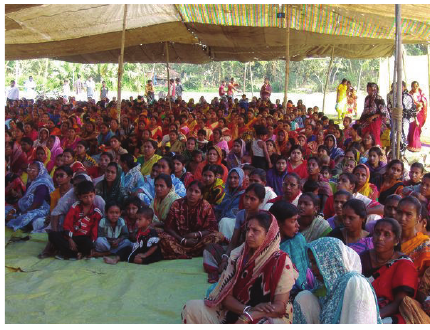
Figure 1: Educational activities on nutrition for mothers.